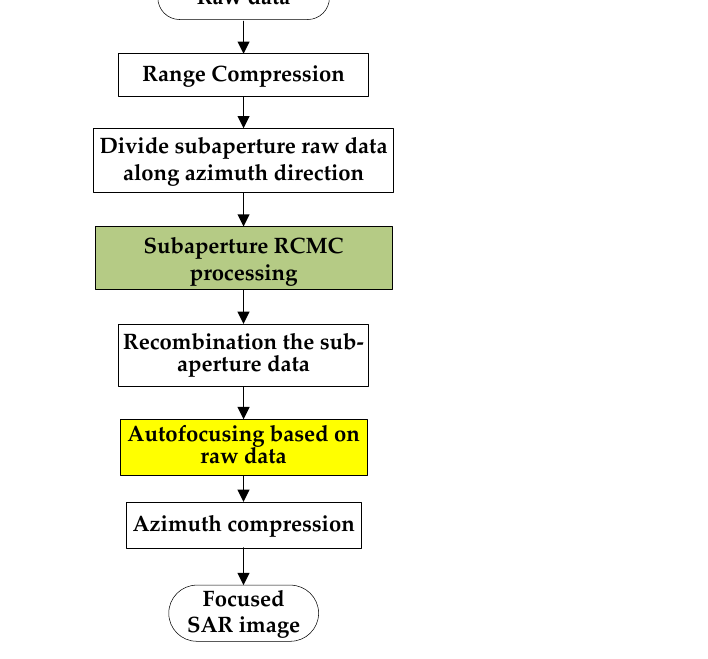
Figure 1. The flow diagram of traditional subaperture imaging processing for low frequency ultrawideband synthetic aperture radar (LF UWB